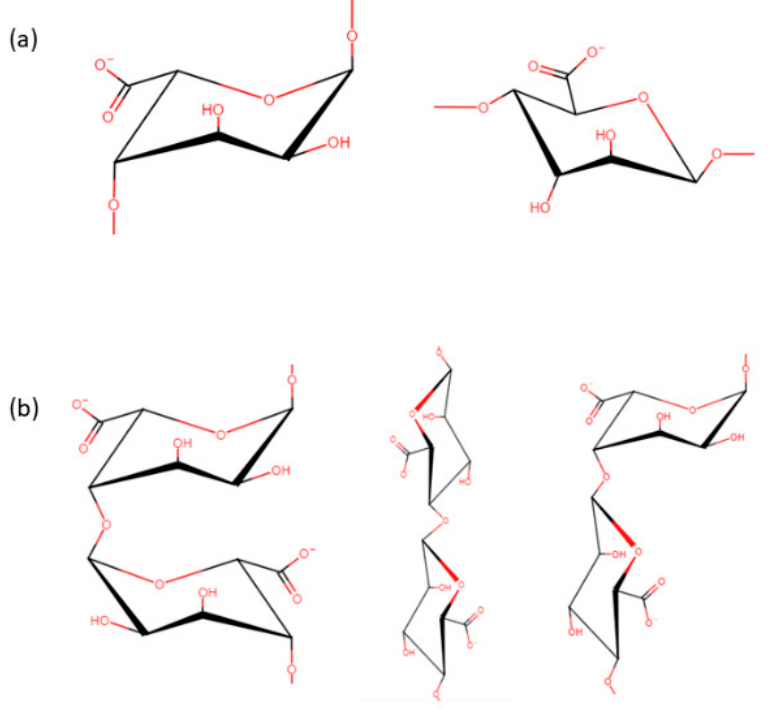
Figure 1. ( a ) α -L-guluronic acid (G) residues and β -D-mannuronic acid (M) residues ( b ) Block configurations. GG MM Mg.